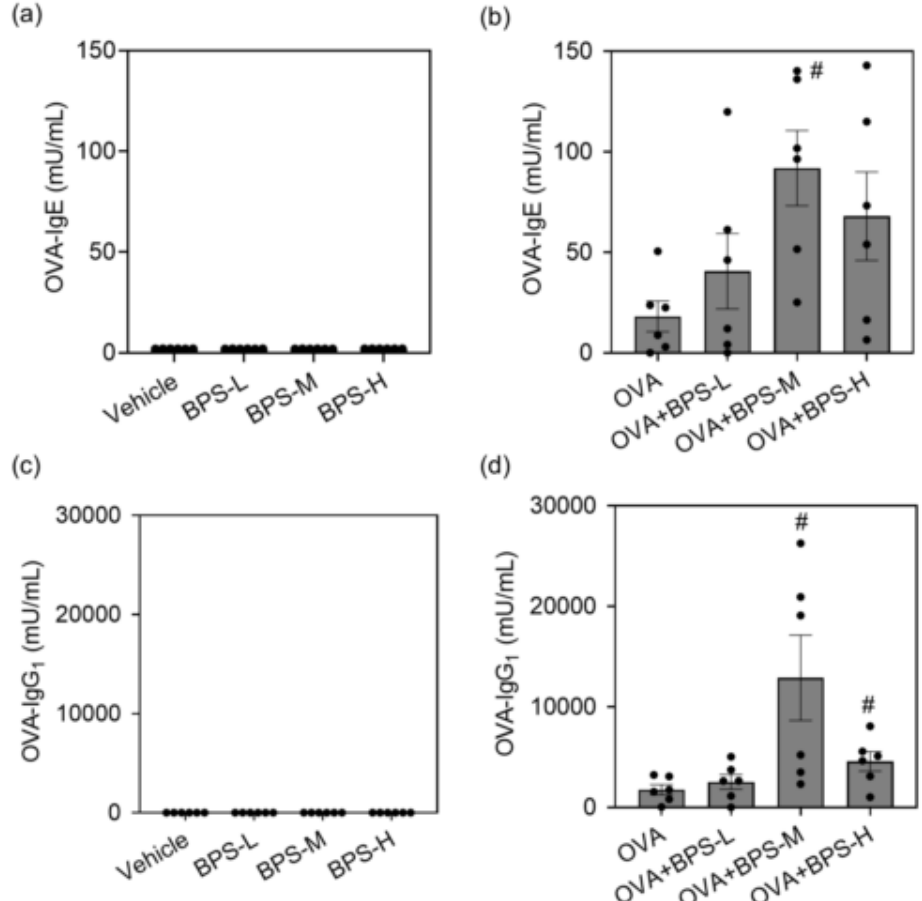
Figure 5. Serum levels of OVA-specific immunoglobulin (Ig) antibodies. OVA-specific IgE and IgG 1 were measured 48 h after the last intratracheal administration by ELISA. ( a , b ) OVA-IgE. ( c , d ) OVA- IgG 1 . Data are expressed as mean ± SE for 5–6 animals per group. # p < 0.05 vs. OVA group. ELISA, enzyme-linked immunosorbent assay; OVA, ovalbumin; SE, standard error.